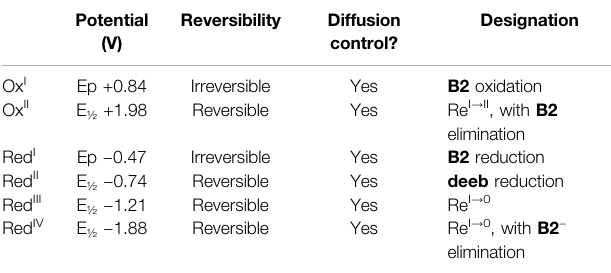
TABLE 2 | Electrochemical characterization summary of fac -[Re(CO) 3 (deeb)B2] +